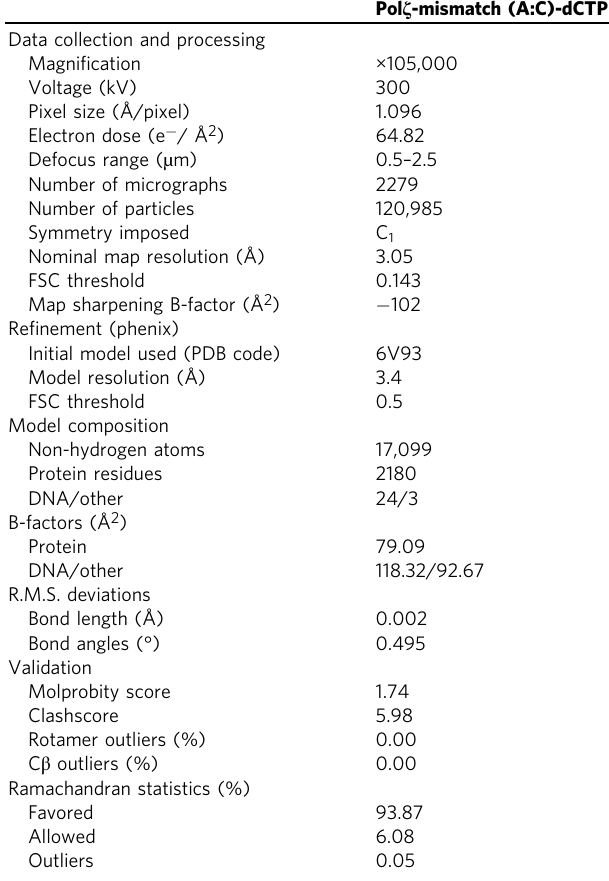
Table 1 Summary of structural and re fi nement